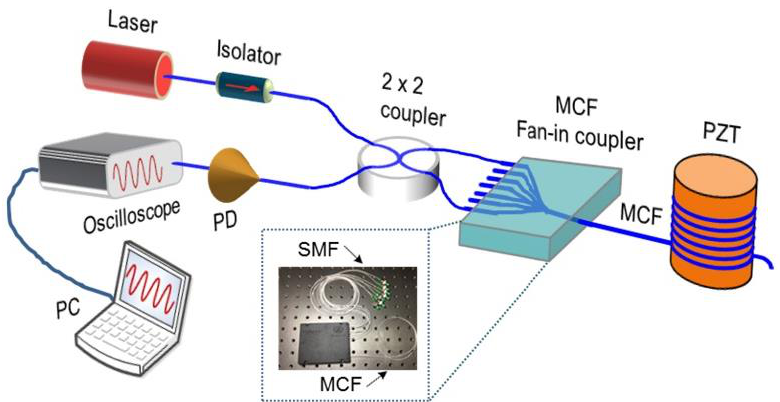
Figure 2. MCF Michelson interferometer sensor fabricated by using the fan-in/out coupler. Reprinted with permission from Ref. [33] © 2018 Optica Publishing Group.